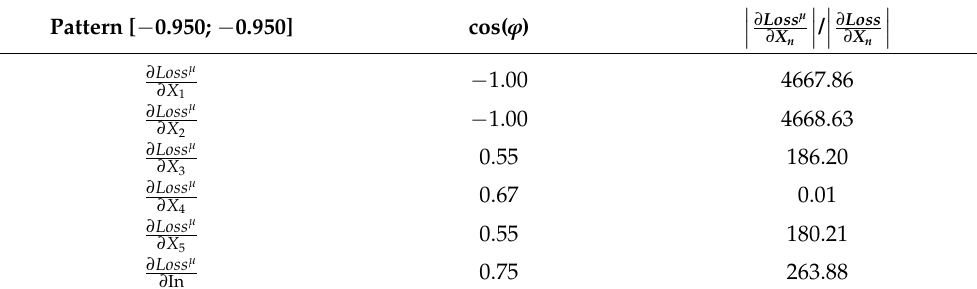
Table 1. The pattern with the largest output error ( x = − 0.950, y = − 0.950), showing the cosine between the partial derivate of the Loss to the working layer in the average case and the particular pattern case and the relationship between their modules.